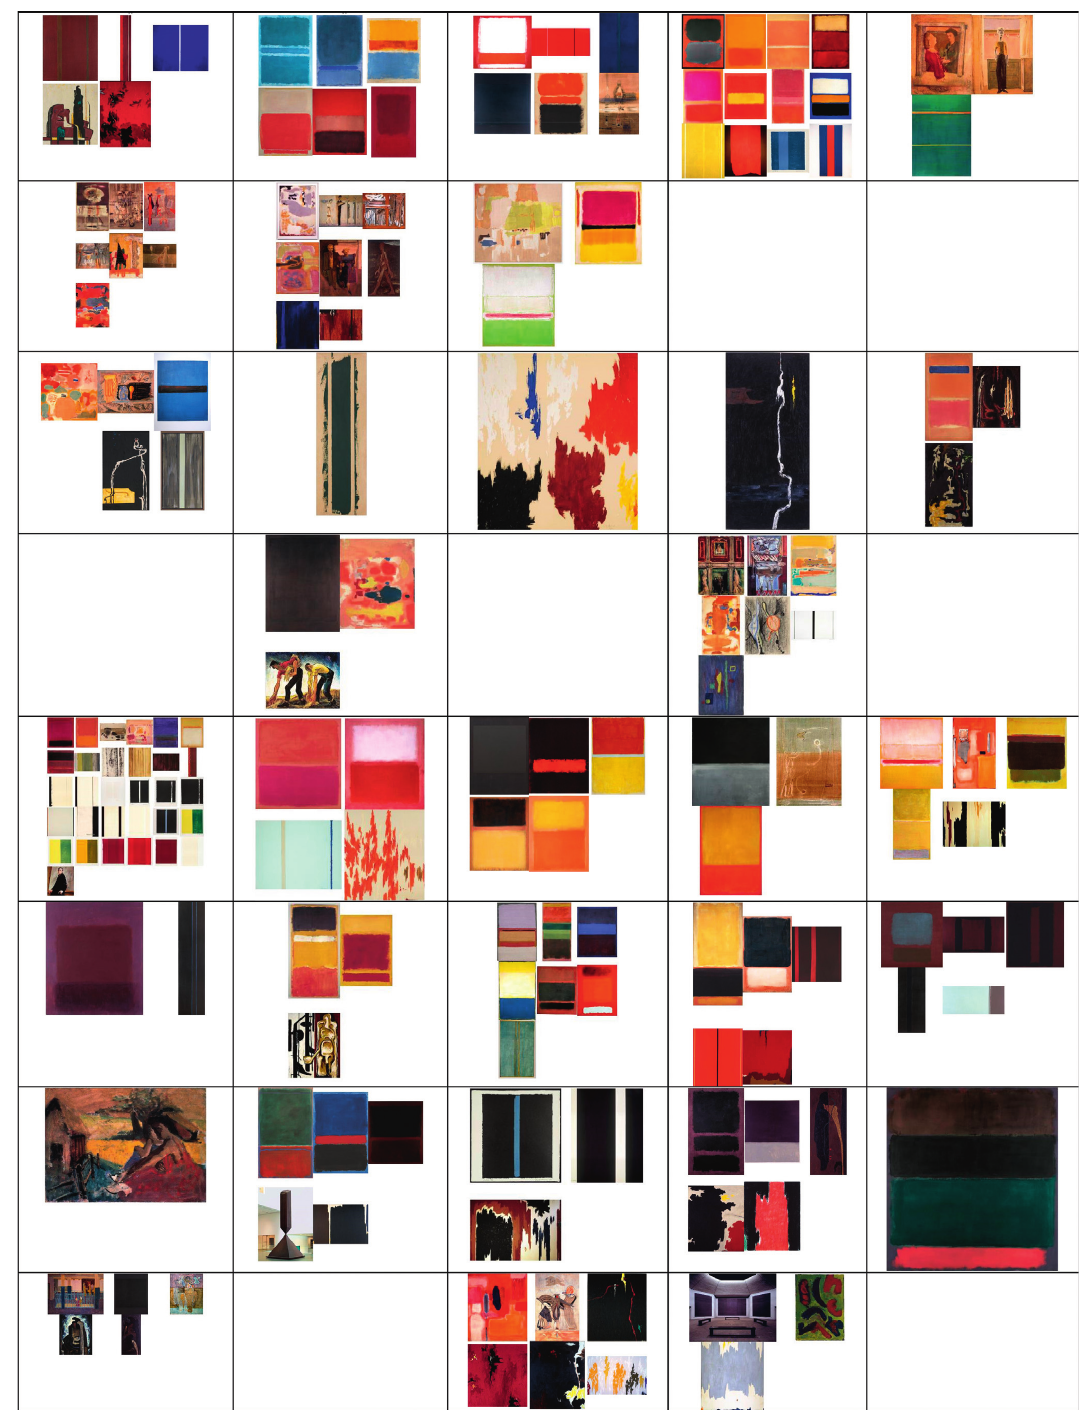
Figure 12: Level 1 SOM of IR with 2 rows and 19 columns. For arrangement constraints, we present the map in a grid of 8 by 5. This 13 internal representation clusters the contrast binary relationship between color palette samples present. The neurons have the following number of elements, respectively (top-down, left-right): 5, 6, 6, 12, 3, 7, 8, 3, 5, 1, 1, 1, 3, 3, 7, 31, 4, 5, 3, 5, 2, 3, 7, 5, 5, 1, 5, 3, 5, 1, 5, 6, and